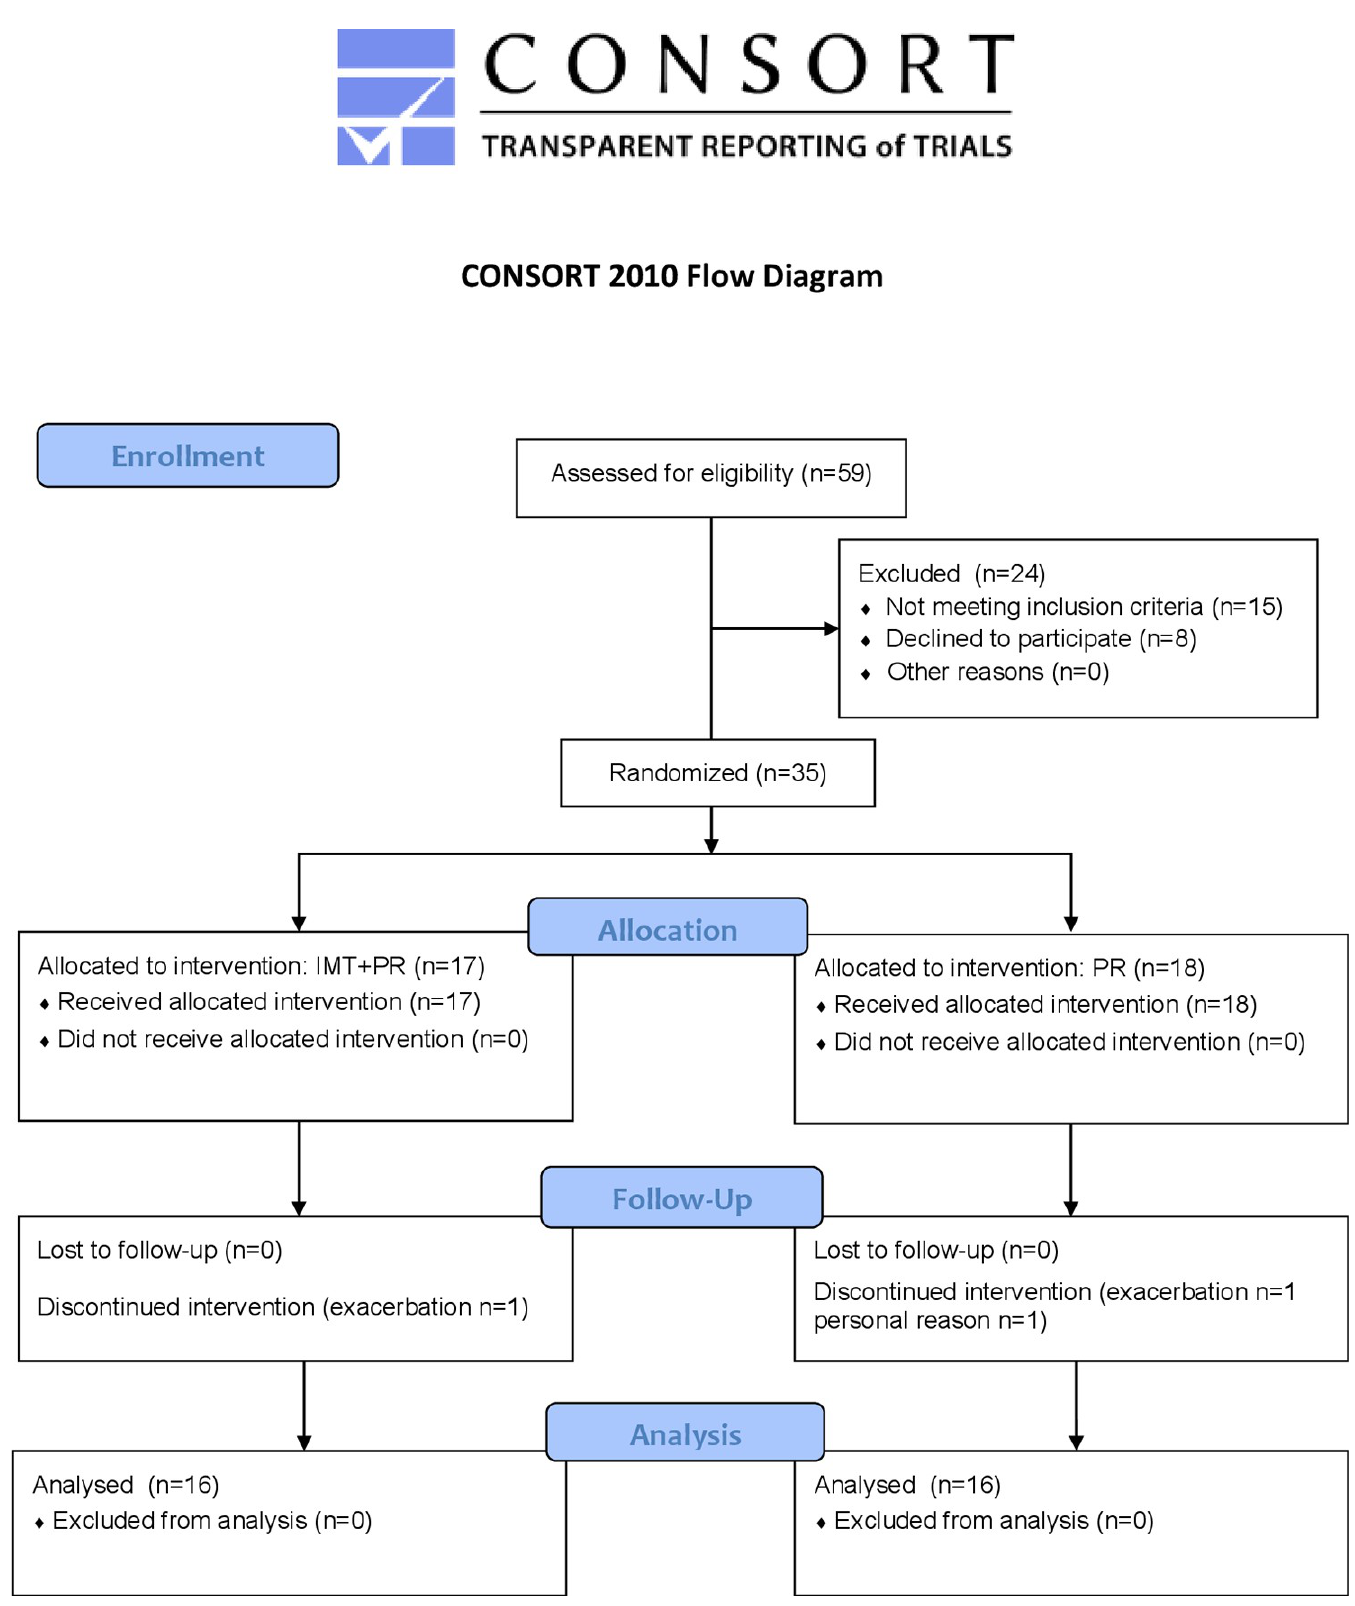
Fig 1. CONSORT (Consolidated Standards of Reporting Trials) 2010 flow diagram. ET: Endurance training; IMT: inspiratory muscle training. https://doi.org/10.1371/journal.pone.0257595.g001 PLOS ONE | https://doi.org/10.1371/journal.pone.0257595 September 23,